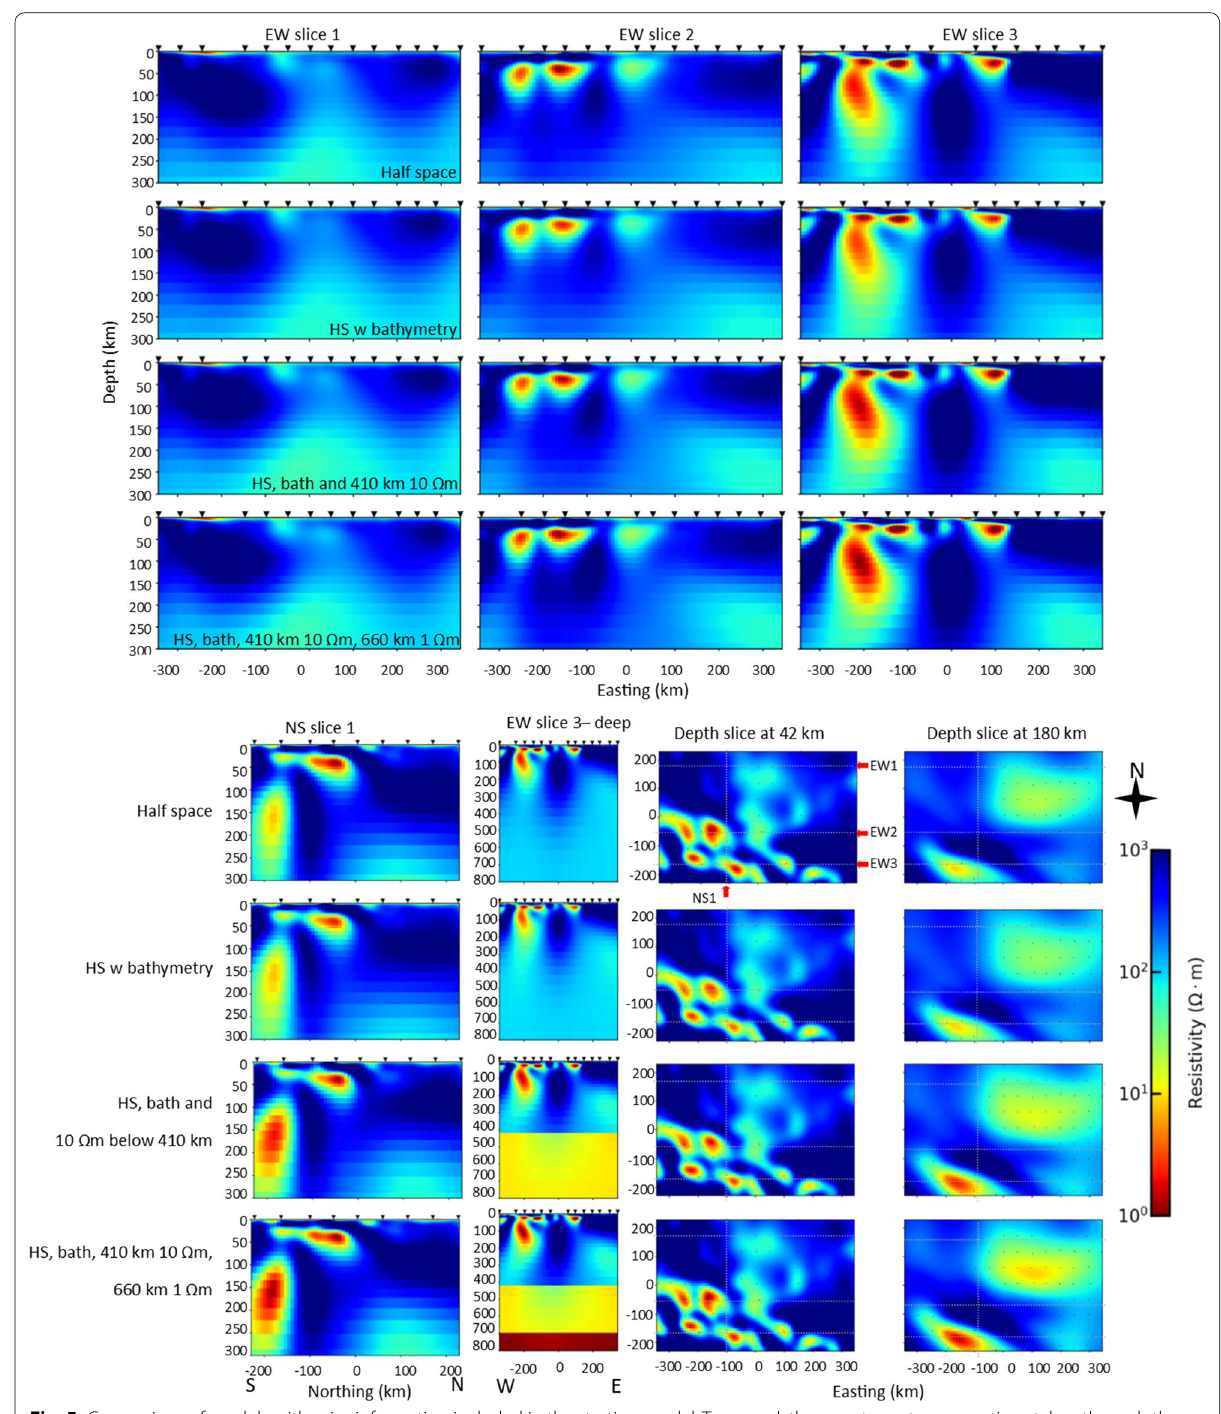
Fig. 5 Comparison of models with prior information included in the starting model. Top panel: three east–west cross sections taken through the four models outlined in Table 1. Locations of these cross sections are shown as grey dashed lines in the bottom panel on the depth slices. Bottom panel, left to right: NS slices through the four models; EW slice 3 down to a depth of 800 km to show the deep mantle conductivity; depth slice at 42 km with cross-section locations shown as grey dashed lines; depth slice at 172 km with cross-section locations shown as grey dashed